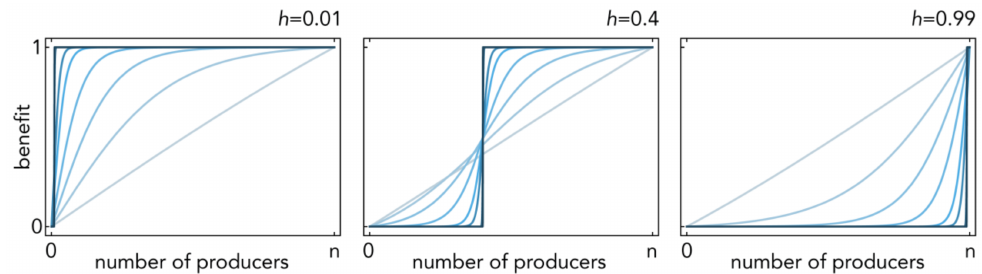
Figure 1. Sigmoid benefits. The benefit b ( i ) of a public good as a function of the number of producers ( i ), described by a normalized logistic function (Equation (9)) with inflection point h ; h → 1 gives increasing returns and h → 0 diminishing returns. Multiple curves are shown, with increasing steepness s (increasing